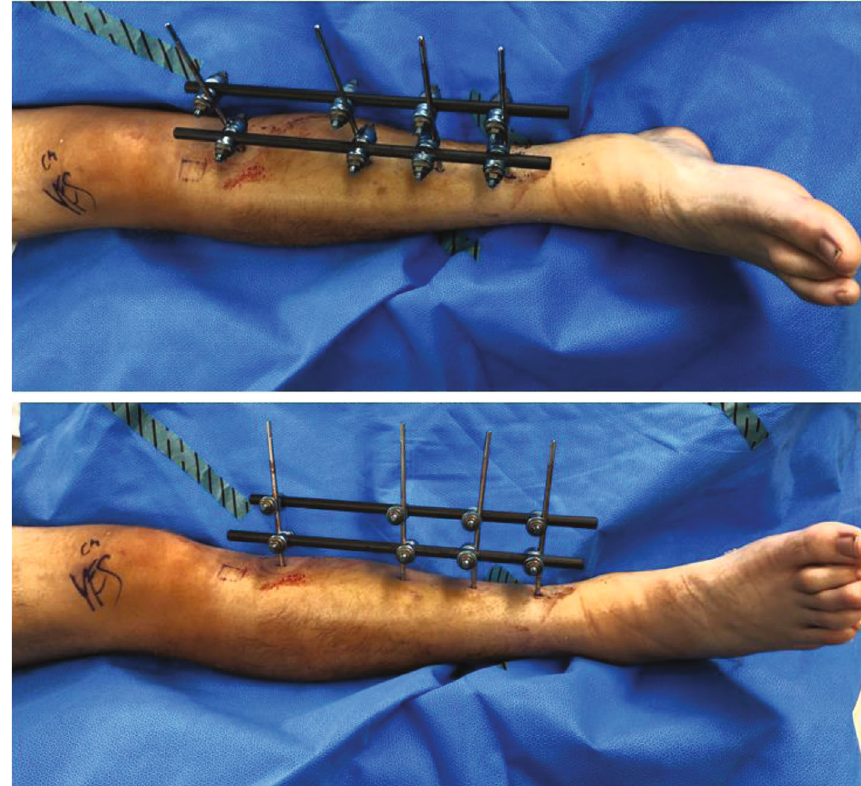
Figure 4: Clinical photographs of patient ’ s external fi xator construct taken at the time of de fi nitive fi xation on postoperative day